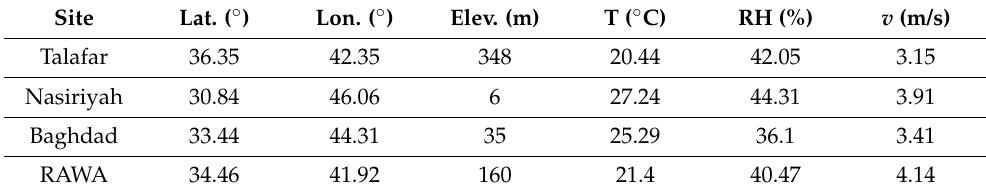
Table 1. Annual statistical characteristics of study area (2017, 2018, and 2019) at 10 m.